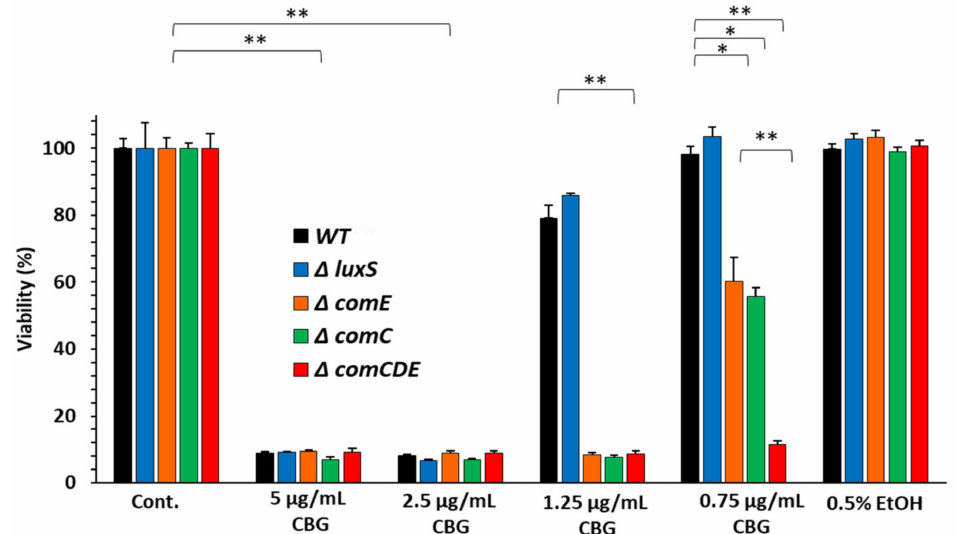
Figure 1. Streptococcus mutans strains deficient in the ComCDE QS system showed increased sensi- tivity to CBG. The viability of different S. mutans strains (WT, ∆ luxS , ∆ comC , ∆ comE and ∆ comCDE ) after a 24 h incubation with increasing doses of CBG (0.75–5 µ g/mL) as measured by OD 595nm . n = 3; * p < 0.05; ** p <